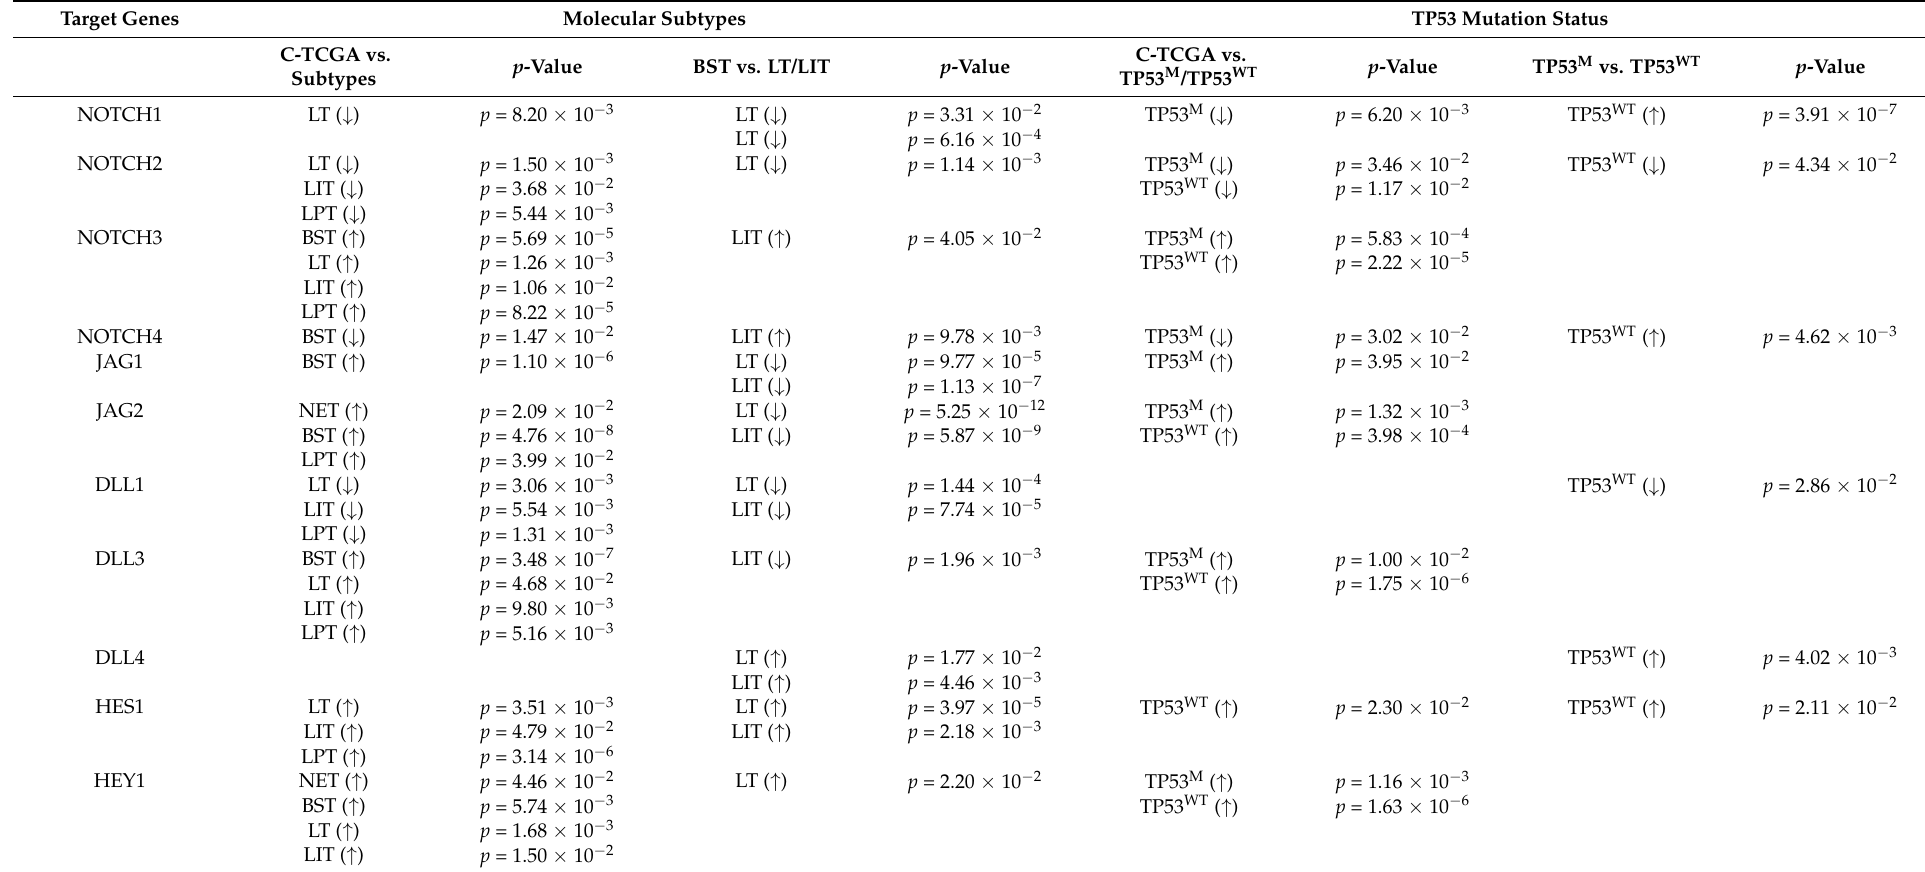
Table 3. Statistically significant differences of expression levels of target genes in subgroups